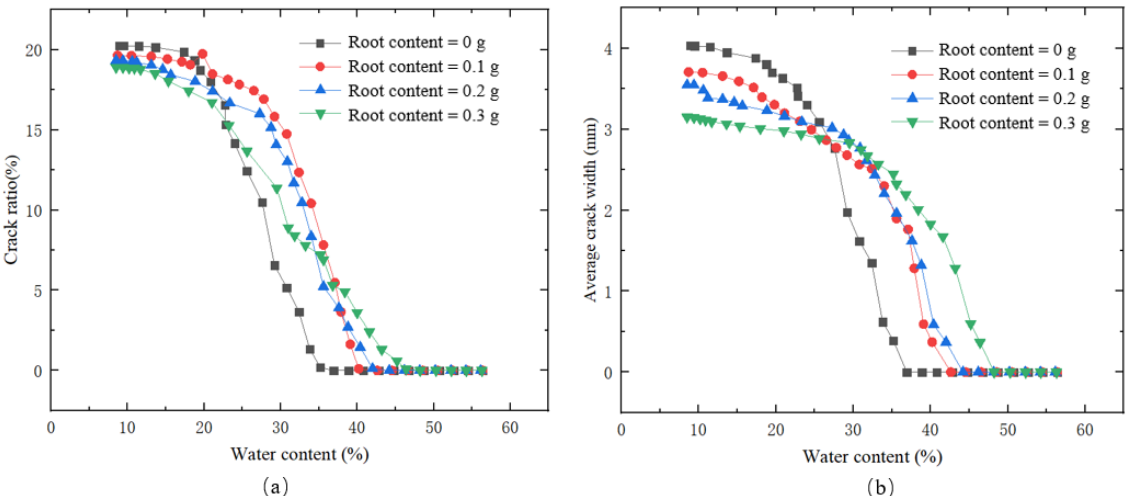
Figure 9. ( a ) Variation in soil fissure rate with water content and ( b ) variation in average width of soil fissure with water